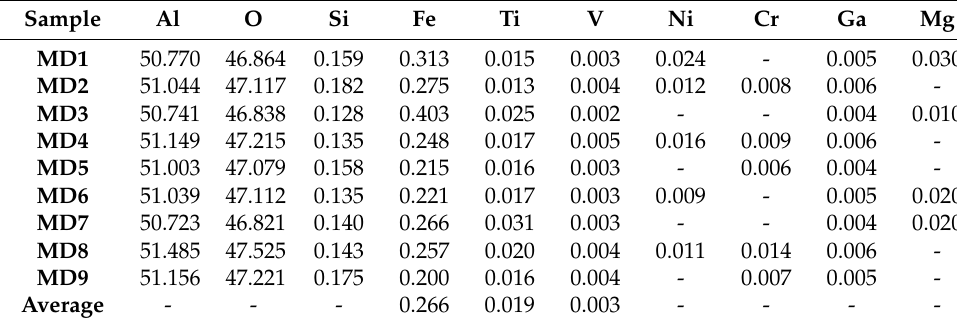
Table 1. Chemical composition of sapphires from Baw-mar mine (Wt.%).